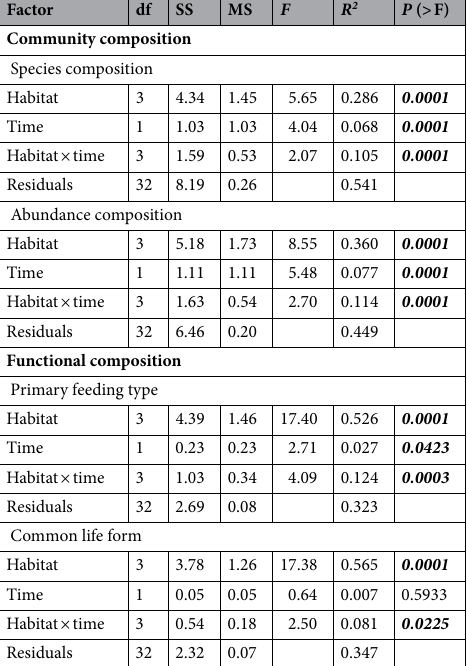
Table 2. Results of permutational multivariate analysis of variance testing for differences in benthic community compositions. Significant P -values ( P < 0.05) are shown in bold italic